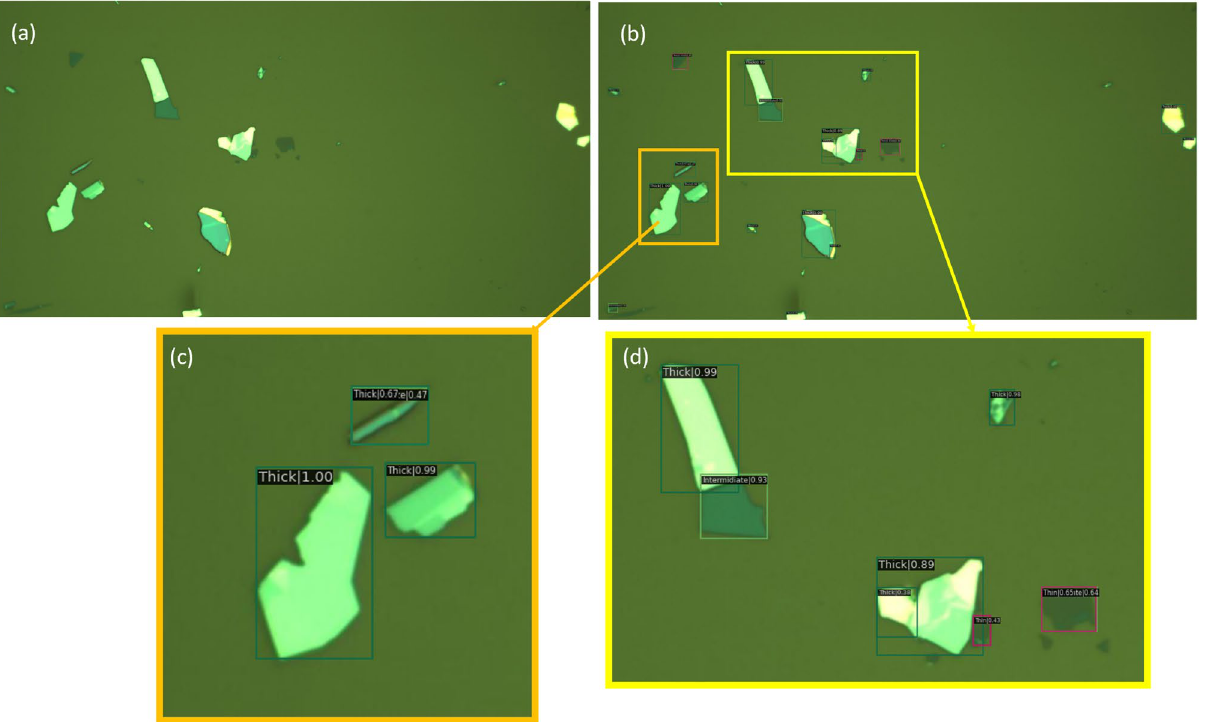
Figure 5. Results obtained from using the proposed algorithm on one image from the Masubuchi dataset; Part ( a ) shows the raw image, part ( b ) shows the labels generated by the algorithm, and parts ( c ) and ( d ) are zoomed-in regions showing the flake type and confidence score reported by the algorithm. We manually identified 16 flakes in the image, and the algorithm correctly classified 12 of them (microscope images obtained from https:// doi. org/ 10. 6084/ m9. figsh are. 11881 053 under the license CC BY